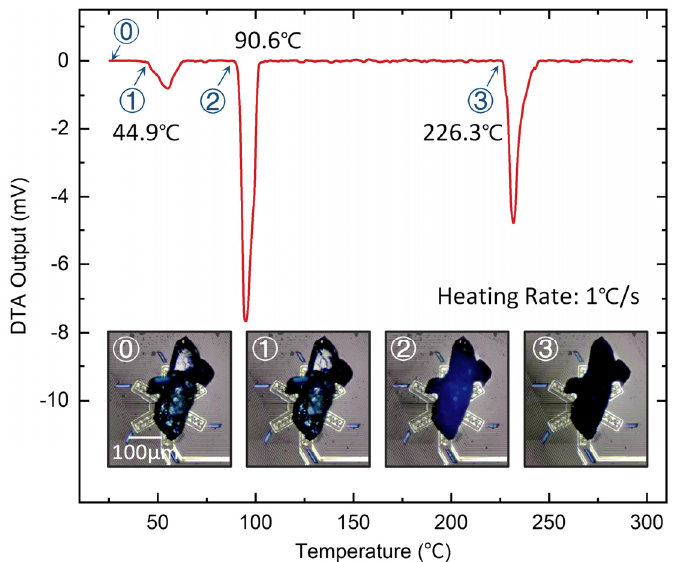
Figure 6. DTA measurement of the dehydration process of CuSO 4 ·5H 2 O using the MEMS thermopile sensors. The dehydration process can be divided into three stages at temperatures of 44.9°C, 90.6°C, and 226.3°C. The optical images show transparency change when CuSO 4 ·5H 2 O gradually becomes CuSO 4 .